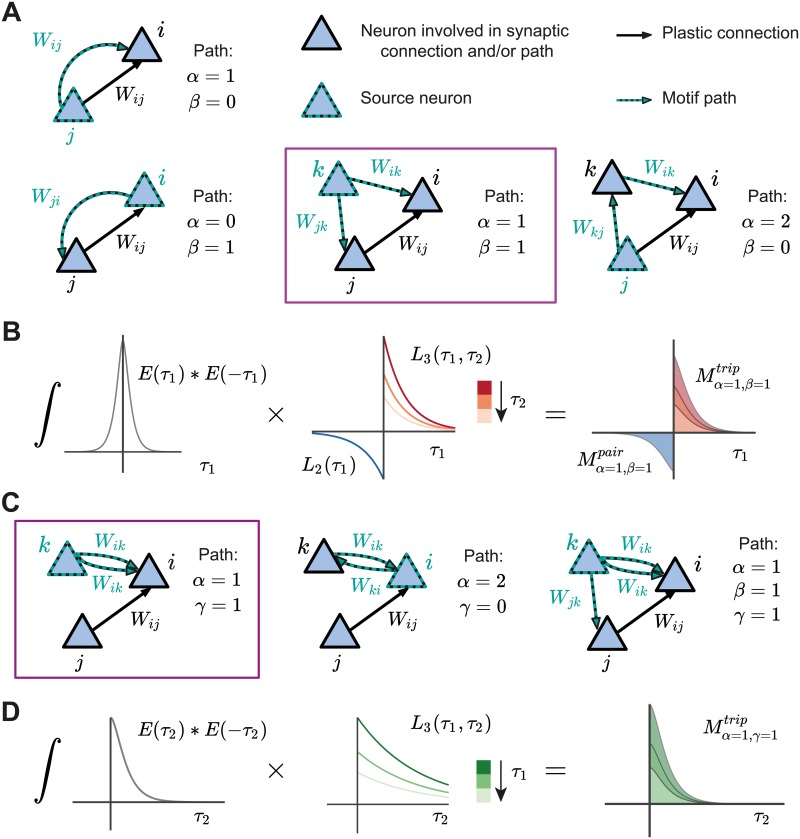
Structural motifs in the network under pair-based and triplet STDP.A. Examples of structural motifs common for both the pair-based and triplet STDP framework. Here α and β constitute the path lengths of synapses from the source neuron to the postsynaptic neuron i and the presynaptic neuron j. α = 1, β = 0: Presynaptic neuron j projects to the postsynaptic neuron i. α = 0, β = 1: Postsynaptic neuron i projects to the presynaptic neuron j. α = 1, β = 1: Common input from source neuron k to presynaptic neuron j and postsynaptic neuron i. α = 2, β = 0: Presynaptic neuron j projects to the postsynaptic neuron i through another neuron k in the network. B. Illustration of the calculation of the common input motif with α = 1 and β = 1 framed in purple in A (there are also additional terms which are not illustrated). The motif coefficients Mα=1,β=1 (right) are calculated as the total area under the curve resulting from the product of the convolution of the EPSC function E (left) and the STDP functions (pair-based L2 and triplet L3, middle). C. Examples of structural motifs found only in the triplet STDP framework, where γ denotes the time-delayed path length from the source neuron to the postsynaptic neuron i. α = 1, γ = 1: Source neuron k projects twice to postsynaptic neuron i with a different time delay. α = 2, γ = 0: Feedback loop through another neuron k in the network (source and projecting neuron are the postsynaptic neuron i). α = 1, β = 1, γ = 1: Source neuron k projects to the presynaptic neuron j and postsynaptic neuron i via all the three possible paths. D. Illustration of the calculation of the motif with α = 1 and γ = 1 for the triplet STDP rule framed in purple in C, compare to B.